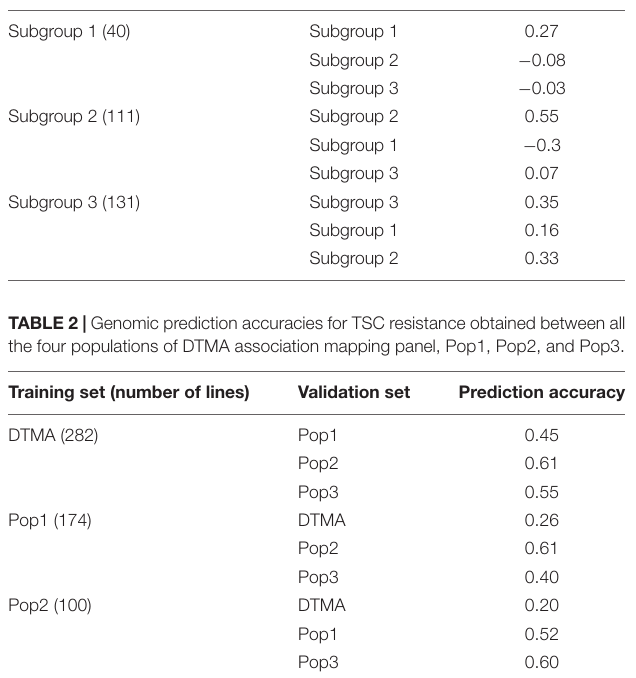
TABLE 1 | Genomic prediction accuracies for TSC resistance obtained between the three subgroups of the DTMA association mapping panel. Training set (number of lines)